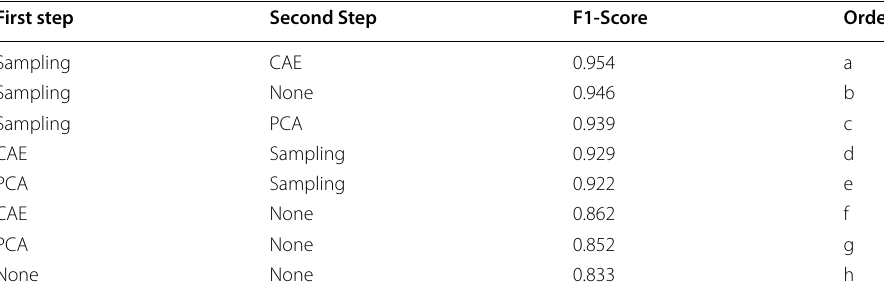
Table 15 Tukey’s HSD results for AUC: scenario